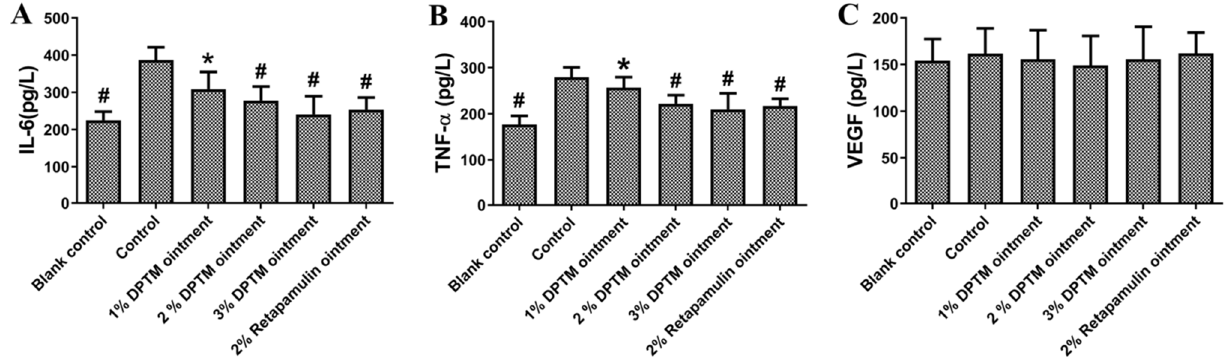
Figure 7. Effect of DPTM and retapamulin ointments on secretions of IL-6, TNF- α , and VEGF. IL-6 ( A ), TNF- α ( B ), and VEGF ( C ). All values are mean ± SD. # p < 0.05 indicates that the blank group, 2% DPTM, 3% DPTM, and 2% retapamulin ointment treatment group vs. the control group; * p < 0.05 indicates 1% DPTM ointment treatment group vs. the 2% retapamulin ointment group.